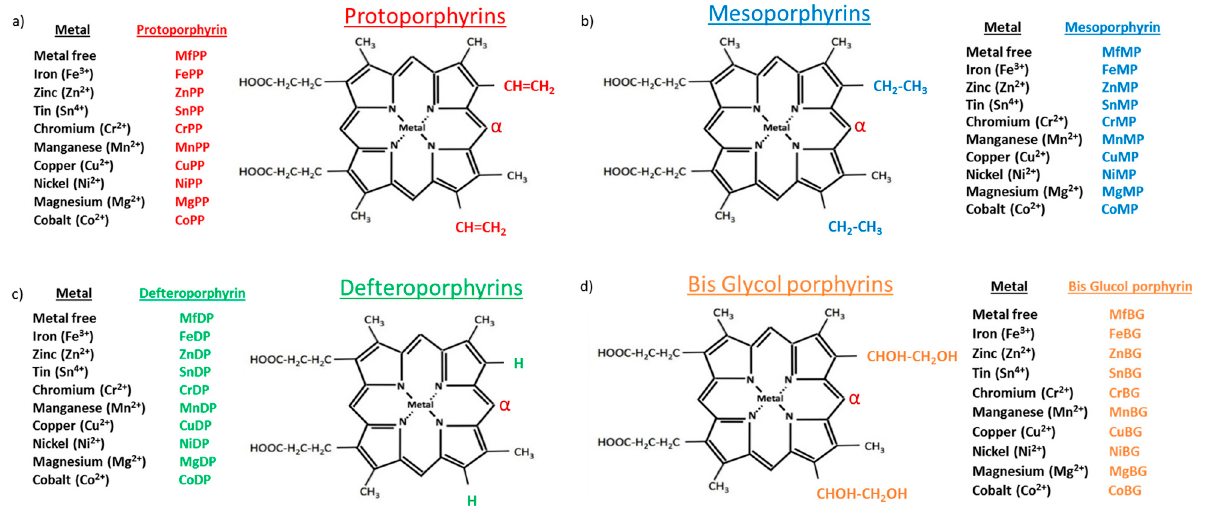
Figure 1. Metalloporphirn (Mps) types. Schematic representation of the chemical structure of Mp molecules depending on the ring substituents (lower right and upper right) and the central metal moiety. Porphyrins catalyzed by HO are oxidized at the α -position (red colour) to yield a tetrapyrrole. Modified from Vreman et al. (2001)